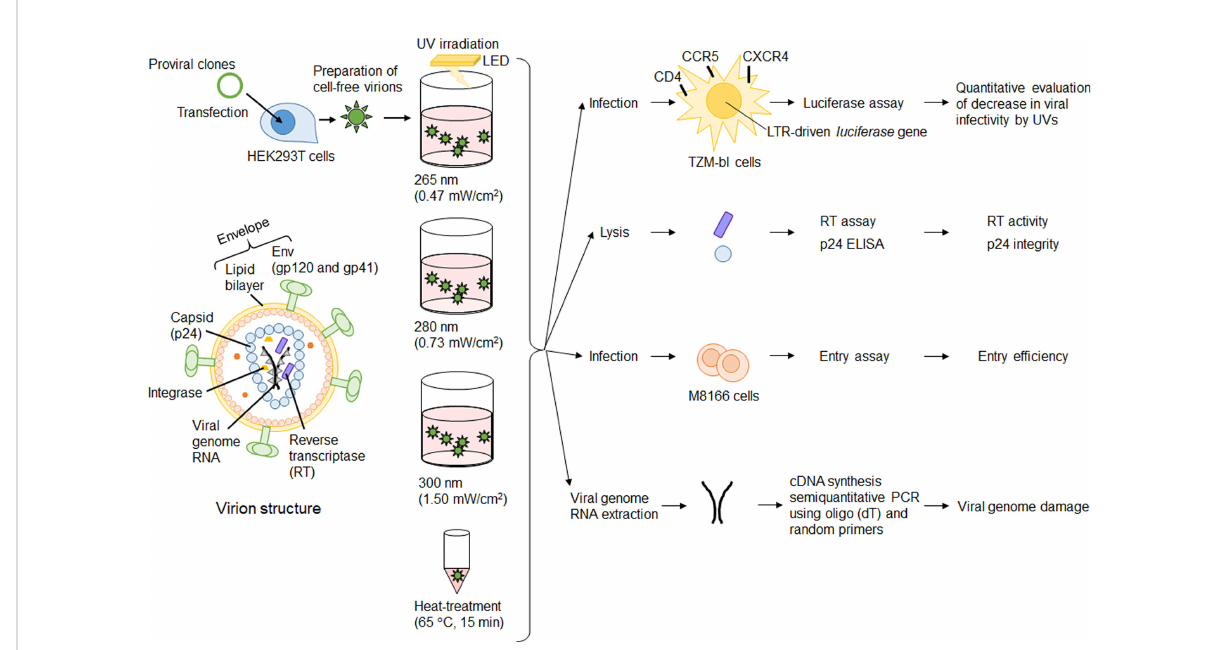
FIGURE 1 Experimental outline. Major virion components are depicted on the left. Cell-free virions were prepared from 293T cells transfected with proviral clones. Cell-free virions were treated with UV or heat, and then used for various assays. Details of assay procedures were described in the Materials and Methods